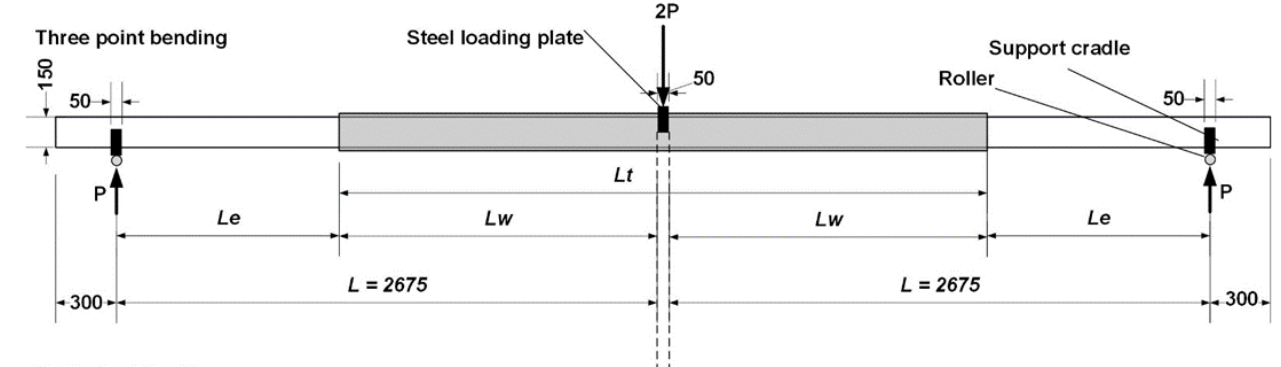
Figure 2. Three-point bending and equivalent cantilevers for tested specimens (units in mm). Table 3. Geometric parameters of experimental specimens.